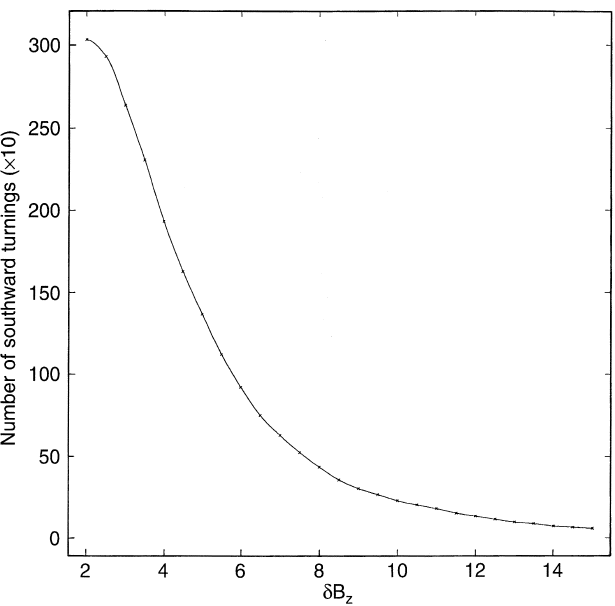
Fig. 3. The number of southward turnings with the change in the hourly B z values, (cid:100) B z , exceeding a given value for the